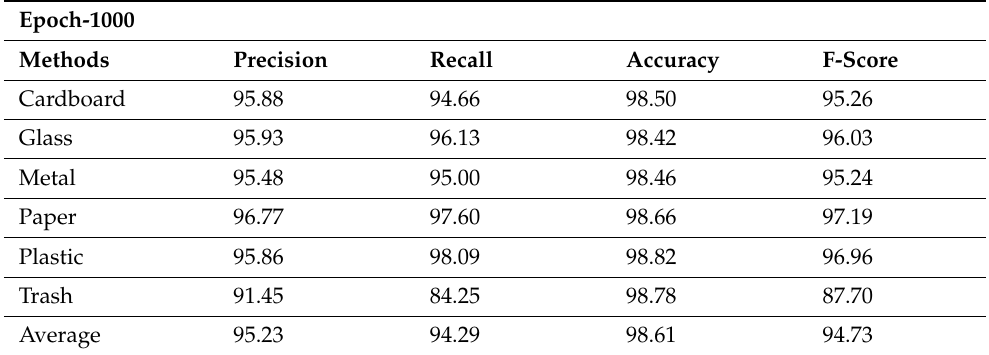
Table 1. Result analysis of DLSODC-GWM technique with different methods under 1000 epochs.